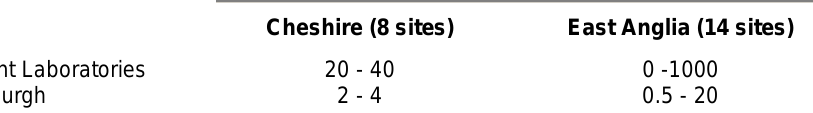
Comparison of Atmospheric NH